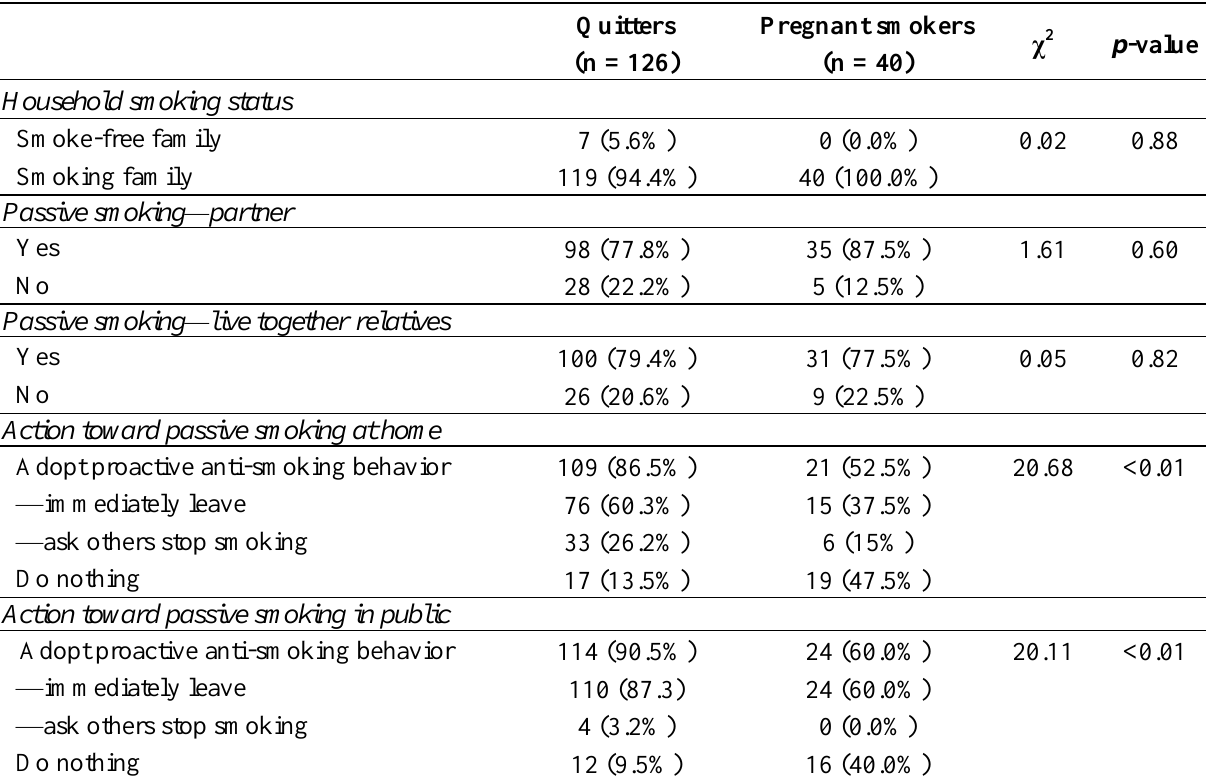
Table 3. Passive smoking of